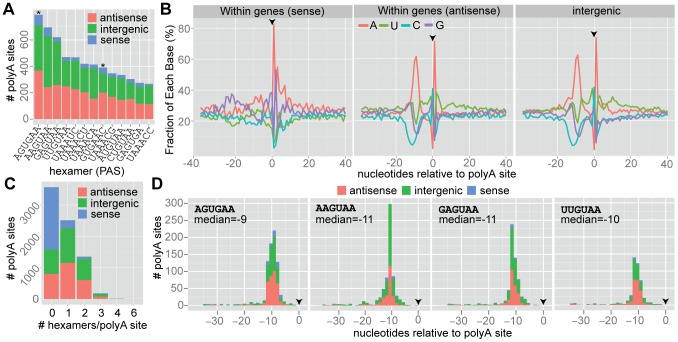
Polyadenylation signals.(A) Prominent hexamer motifs identified in 3′ transcript fragments (data from the WB isolate). The hexamers were identified using the procedure described by Beaudoing et al. Positions −40 to −1 relative to the polyadenylation site were searched. One 3′ fragment can contain more than one PAS hexamer and therefore be counted twice. Asterisks (*) indicate hexamers that have previously been reported as putative G. intestinalis polyadenylation signals. (B) Nucleotide composition surrounding polyadenylation sites that occur sense, antisense, and intergenic with respect to protein-coding genes. Red, green, blue, and violet correspond to nucleotides A, U, C, and G. The x-axis shows the nucleotide position in relation to the polyA site (black arrow). The y-axis shows the percentage of each base. (C) Frequency of unique hexamers in transcript 3′ fragments (nucleotides −40 to −1 relative to the polyA site). The x-axis shows number of unique motifs found, and the y-axis shows the number of 3′ fragments (split on antisense, sense, and intergenic sites). (D) Histograms of the position of the four most frequent hexamers in relation to the polyA site (black arrow). The position on the x-axis refers to the last nucleotide of the hexamer.